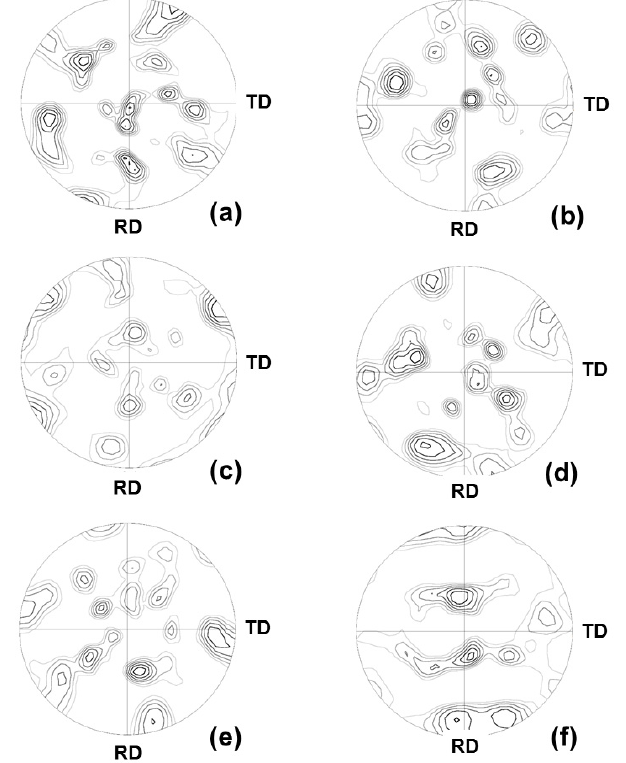
Figure 6. {111} pole figures of FePd alloy at 700 °C after ( a ) 1 min; ( c ) 2 min; and ( e ) 48 h for 50% cold rolling, and after ( b ) 10 s; ( d ) 20 s; and ( f ) 60 s for 90% cold rolling.